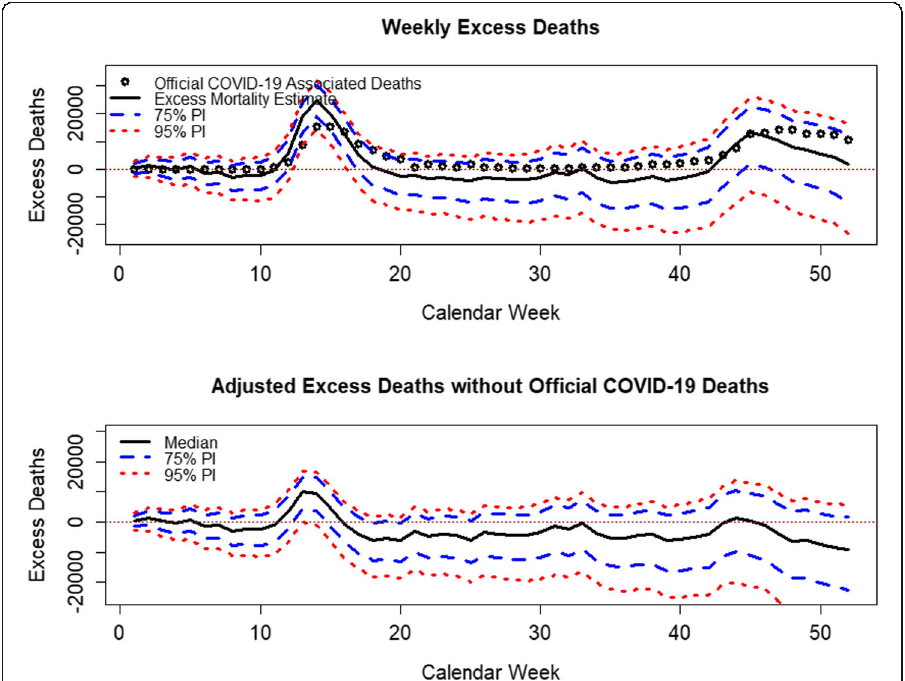
Fig. 10 Excess mortality distribution with official COVID-19-associated deaths by calendar week for 18 study countries. Sources: European Centre for Disease Prevention and Control (2021a); Human Mortality Database (2021); Computations and design by the